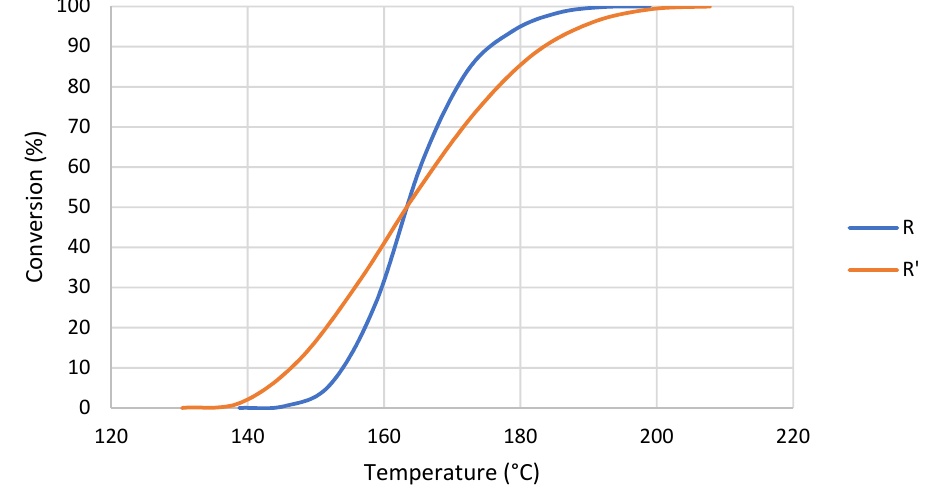
Figure 5. Conversion curves at 10 °C/min of R and R’.